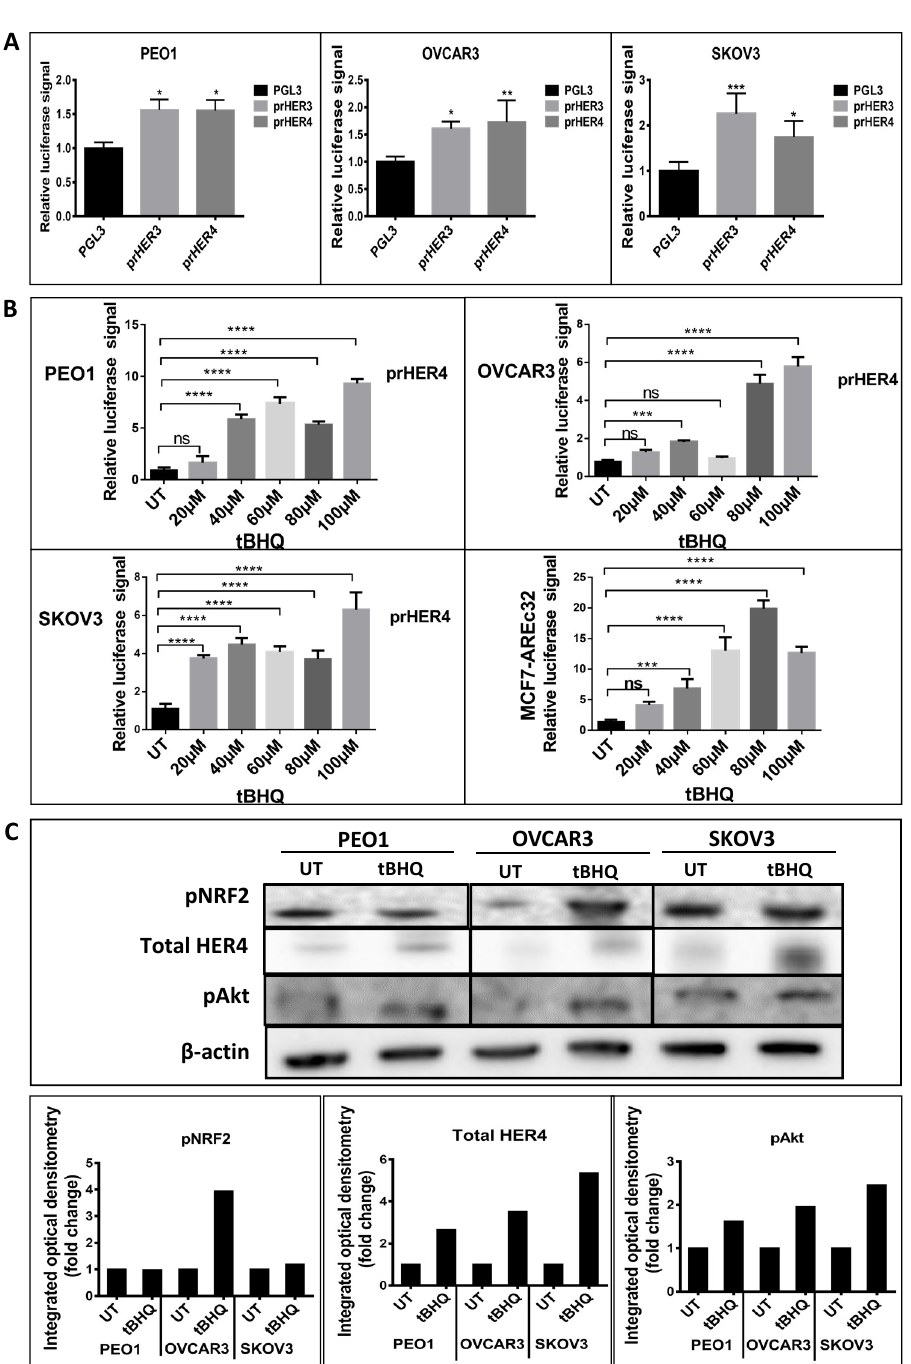
Figure 1. NRF2 regulation of HER4 expression. (A) Ovarian cancer cell lines demonstrate basal transcription of HER3 and HER4 respectively. Cell lines were transfected with either control pGL3 vector or pGL3 vector with fragments of either HER3 (prHER3) or HER4 (prHER4) promoter driving expression of luciferase. Data shown are mean of triplicates normalized to the value of pGL3 [ANOVA followed by Tukey’s post hoc test (*: P <0.05, **: P < 0.01, ***: P < 0.001)]; (B) tBHQ treatment increases transcription of HER4 in a dose dependent manner. MCF7-AREc32 contains stably cloned 8 × cis -ARE driving NRF2 dependent expression of luciferase gene [8]. Means ± standard deviation (SD) of triplicates normalized to the value of untreated (UT) are shown [ANOVA followed by Tukey’s post hoc test (***: P < 0.001 and ****: P < 0.0001; ns = non-significant)]; (C) western analysis following 24 h treatment with tBHQ (100 μM) indicated increased HER4 and pAkt expression in all cell lines. Bar charts indicate fold-changes